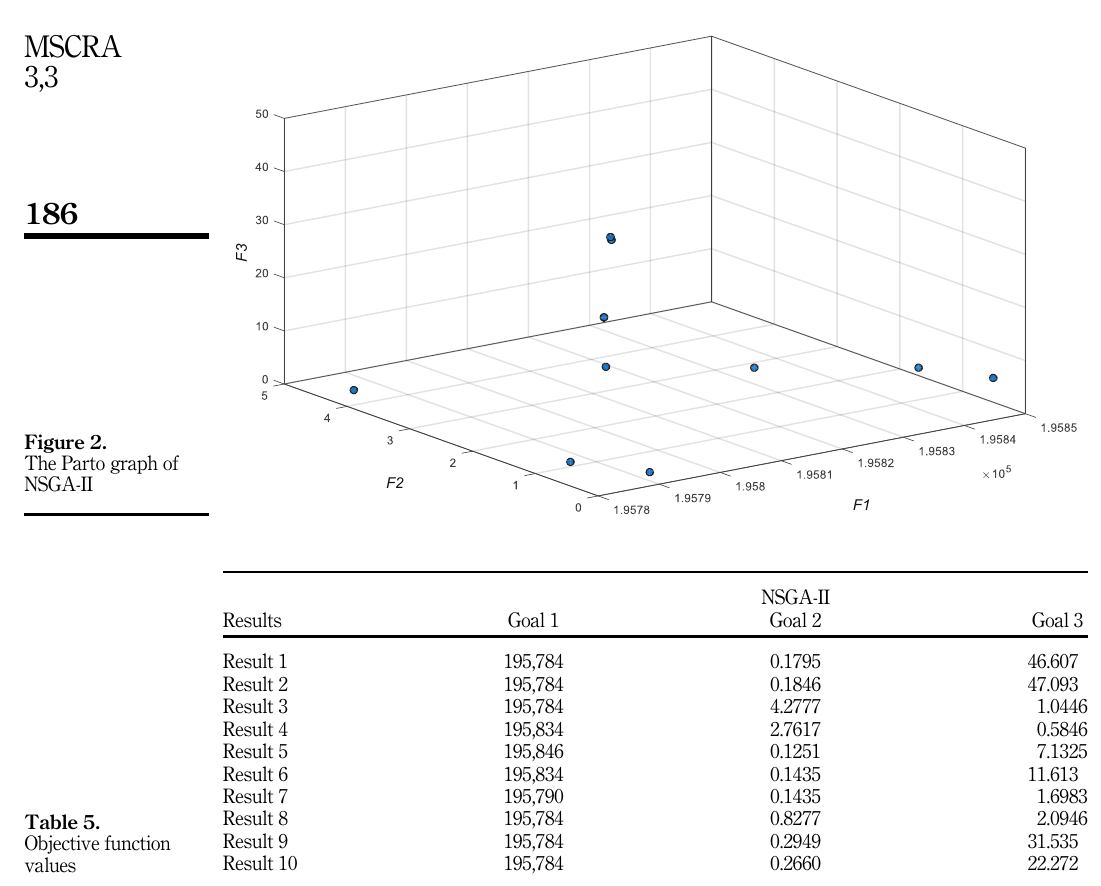
Figure 2. The Parto graph of NSGA-II